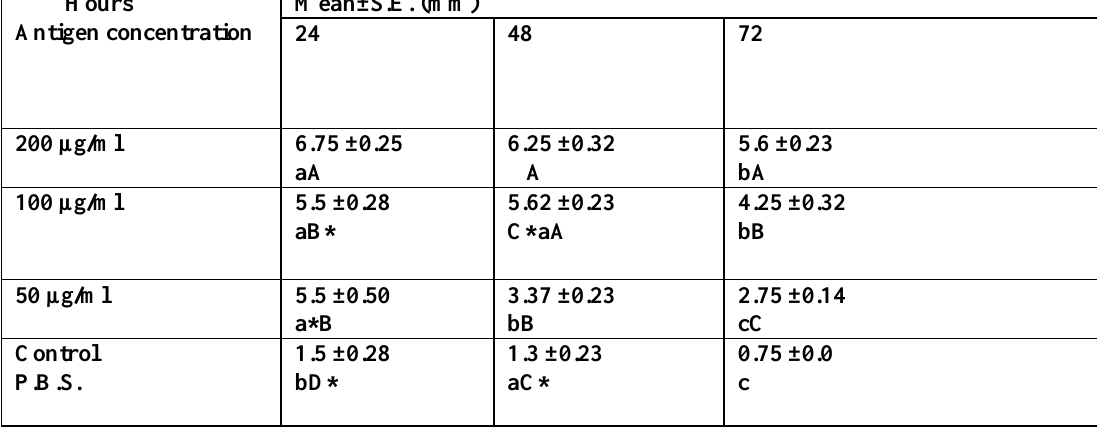
Table 6: Induration of delayed type hypersensitivity in the immunized rabbits